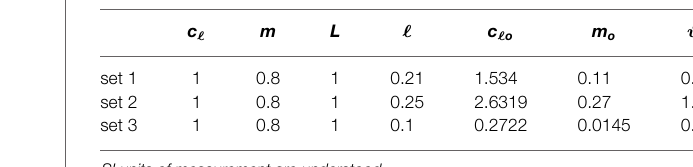
TABLE 1 | Sets of parameters for selected triangular lattices with resonators whose frequency dispersion (see Figure 3 ) is Dirac-like at ω = π